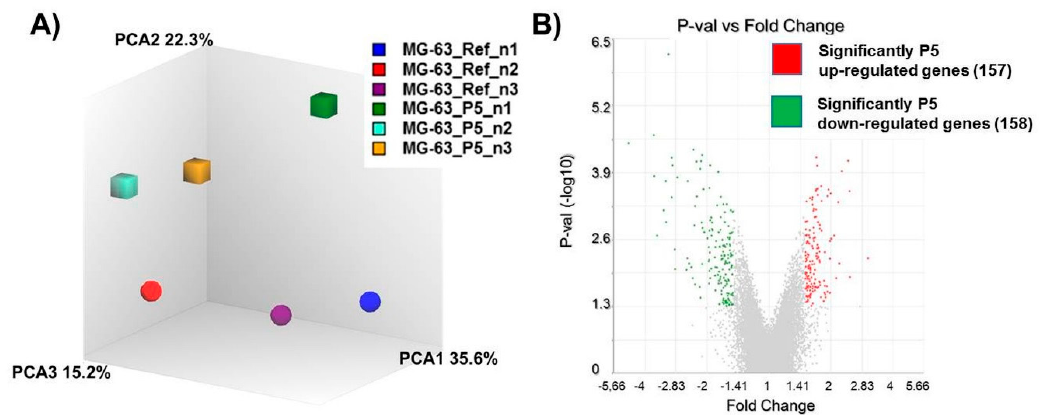
Figure 2. Gene expression profiling of MG-63 cells on micro-pillars (P5) compared to unstructured reference (Ref). ( A ) Principal component analysis (PCA) 3D mapping from complex microarray datasets of MG-63s on P5 (upper row, square) and on Ref (lower row, circle) to determine the variation of gene profiles (21,448 genes) of the individual expression profiles of the 3 independent experiments. Fractions of percentage of variation out of the total mapped di ff erence (73.1%) among samples were signified on each axis. Note that the gene expression profile of MG-63s on P5 is clustered di ff erently in each of the corresponding experimental approaches compared to the cells on Ref (vertical shift). ( B ) Volcano Plot visualization of di ff erentially regulated genes in cells on P5 compared with Ref (red scatter plot = P5 up regulated genes; green scatter plot = P5 down regulated genes). Note that the colored points indicated a significantly di ff erent regulation in the mRNA expression pattern on P5 versus Ref with algorithm setting. Only 315 genes (1.47%) pass the filter criteria: Fold change > 1.5 or < − 1.5, LIMMA (linear models for microarray data) statistics p < 0.05. (Analysis by TAC 4.0 software (Transcriptome Analysis Console)).